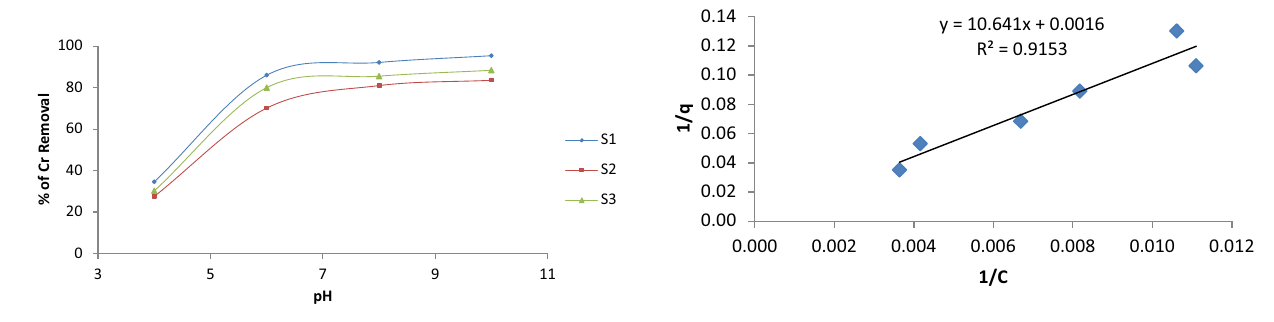
Fig. 15 Langmuir adsorption isotherm of spent tea